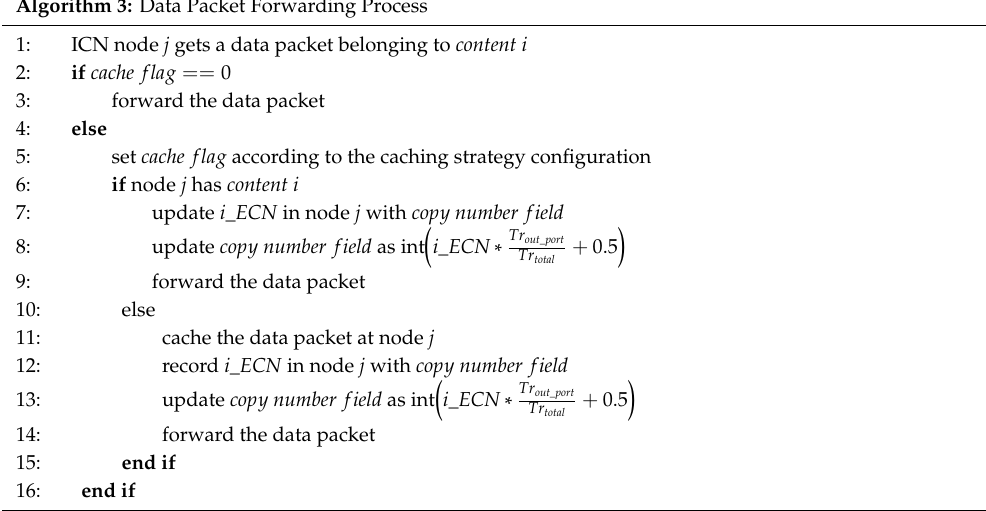
Algorithm 3: Data Packet Forwarding